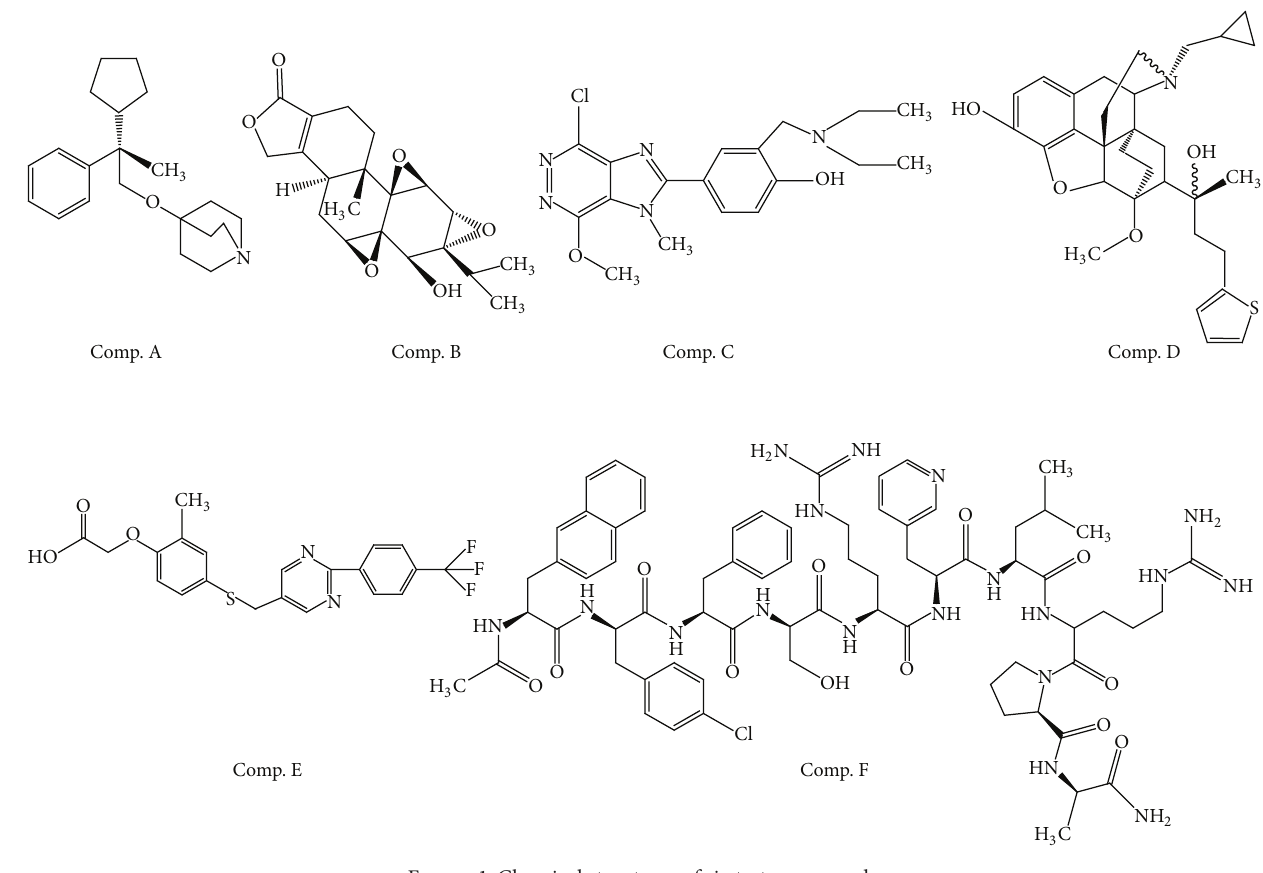
Figure 1: Chemical structures of six test